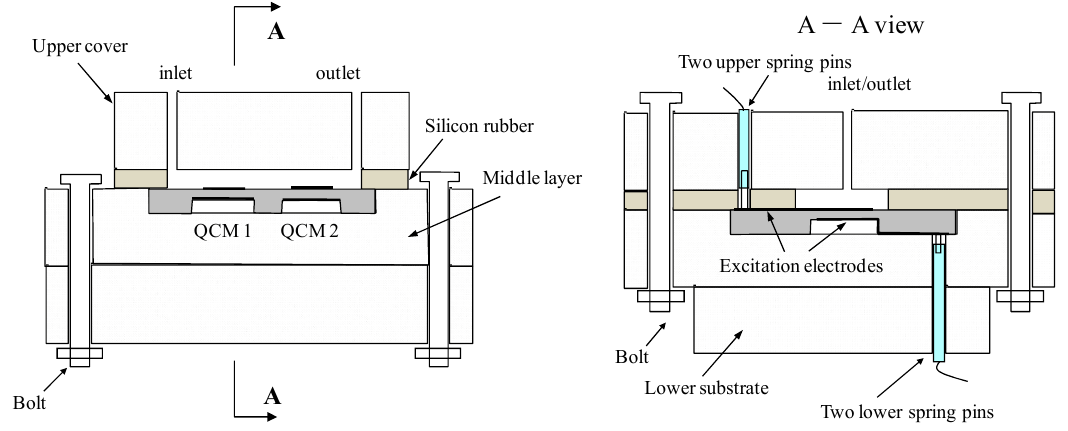
Figure 2. Schematic illustration flow cell for the dual-channel QCM sensor, the right one is the A-A view of the left one.